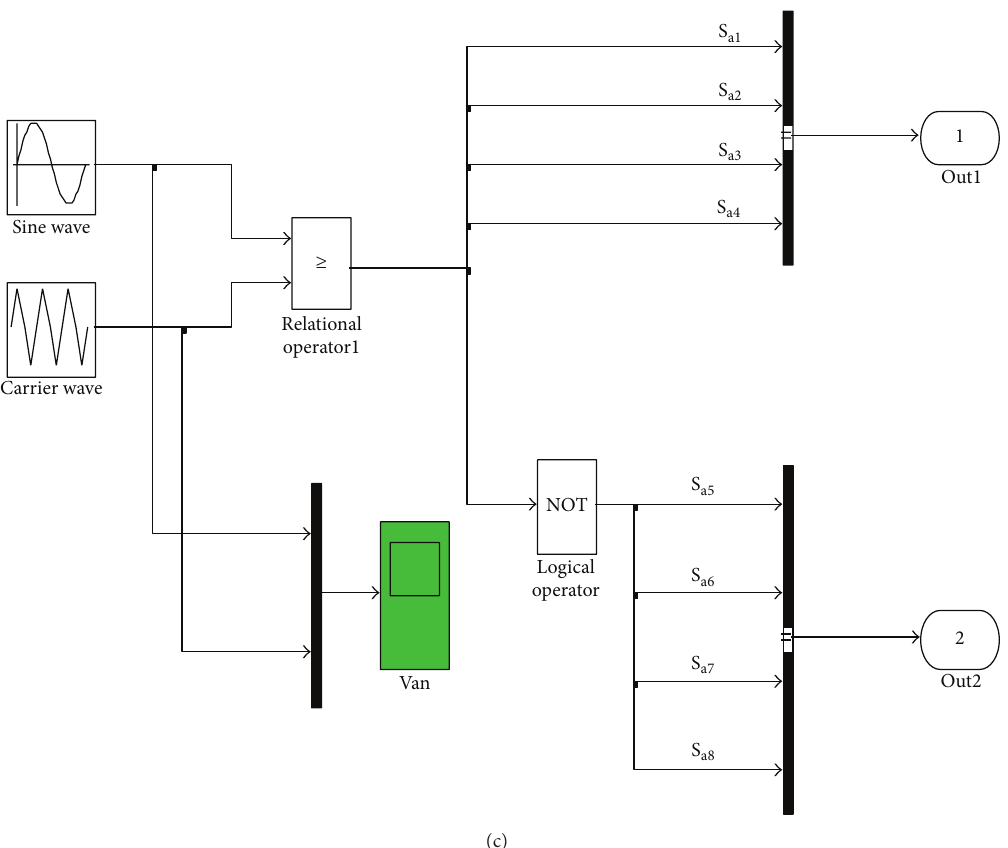
Figure 3: Modulation schemes: (a) five-level inverter, (b) five-level inverter as three-level inverter, and (c) five-level inverter as two-level